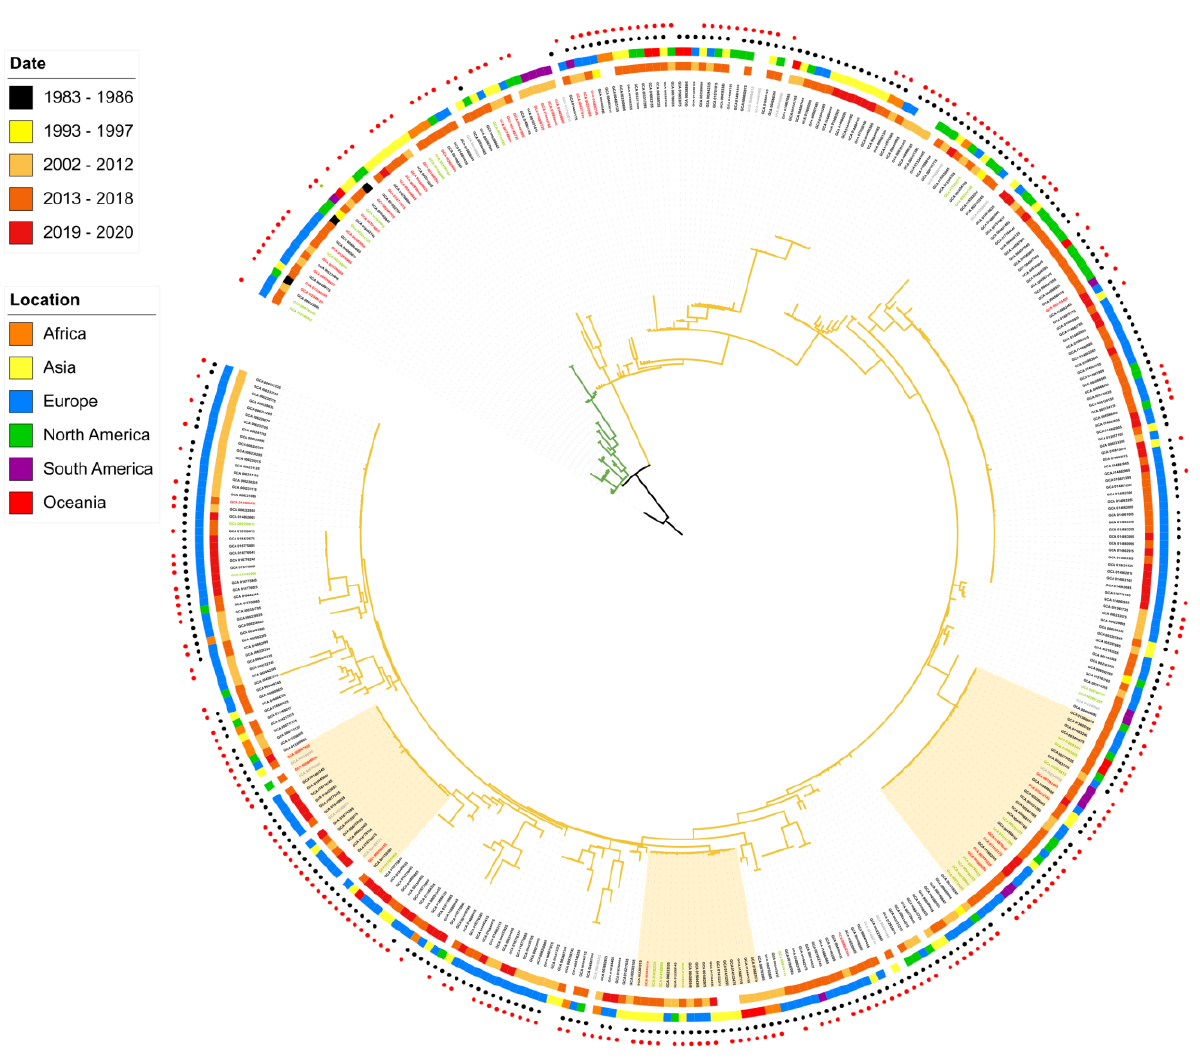
Figure 2. Core SNP tree based on E. coli ST38 genomes. Highlighted branches represent Clade 1 (green) and Clade 2 (yellow). The colored circles outside the tree, from innermost to outermost, represent metadata of isolation date and origin, respectively. Genomes carrying the high-pathogenicity island (HPI) and the second T3SS (ETT2) are marked with black and red circles, respectively. The EC35 genome from Brazil obtained in this study is featured by a green star. Highlighted labels represent genomes from human (black), animal (red), environmental (green), and unknown (grey) sources. The yellow hatched regions highlight the occurrence of identical genomes among different sources, demonstrating the zoonotic character of ST38. This figure with a better resolution was also provided in the Supplementary Material (Figure S3).